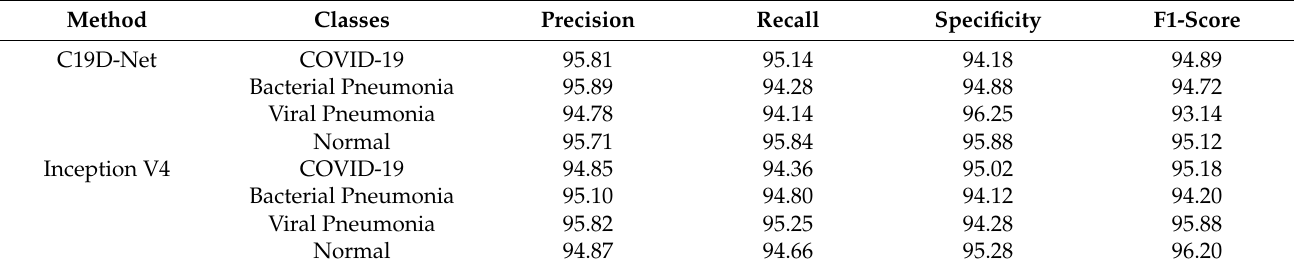
Table 5. Comparison based on the performance of four-class C19D-Net, InceptionV4.